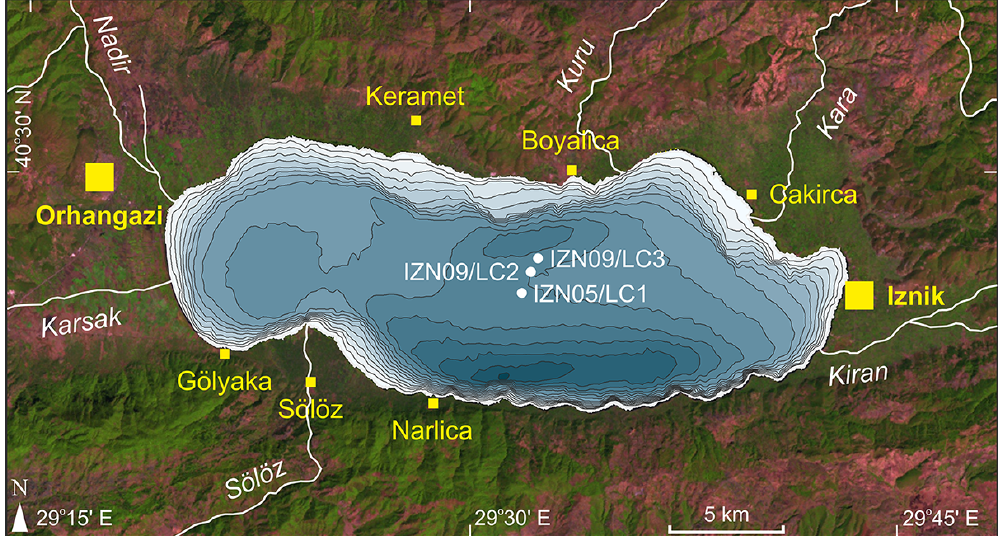
Figure 2. Lake Iznik with bathymetric curves in 5m intervals modified from Roeser et al. (2012). Dots indicate the coring locations, and squares indicate